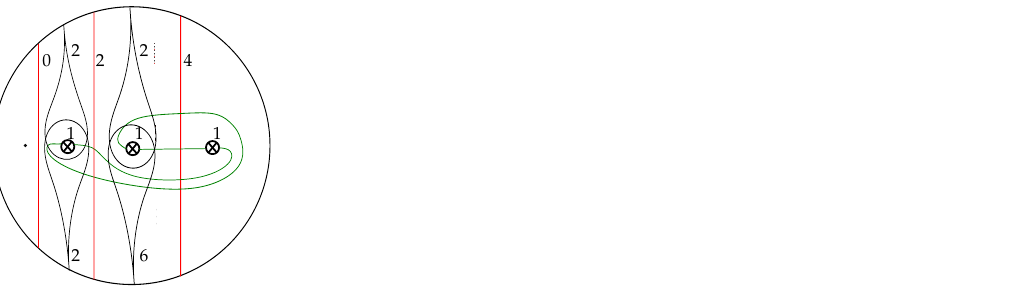
) = ( 1, 1; 0, 2; 1, 1, 1 ) . L − −